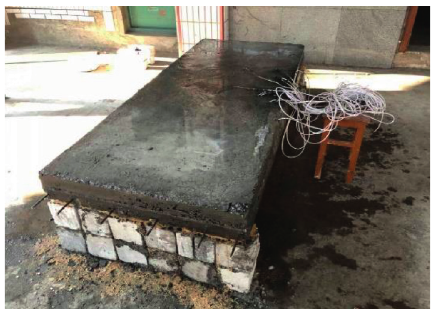
Figure 5: Photograph of the prepared LPCSHTHSC.